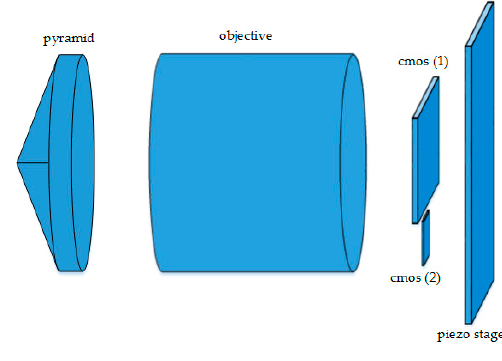
Figure 3. Payload concept.